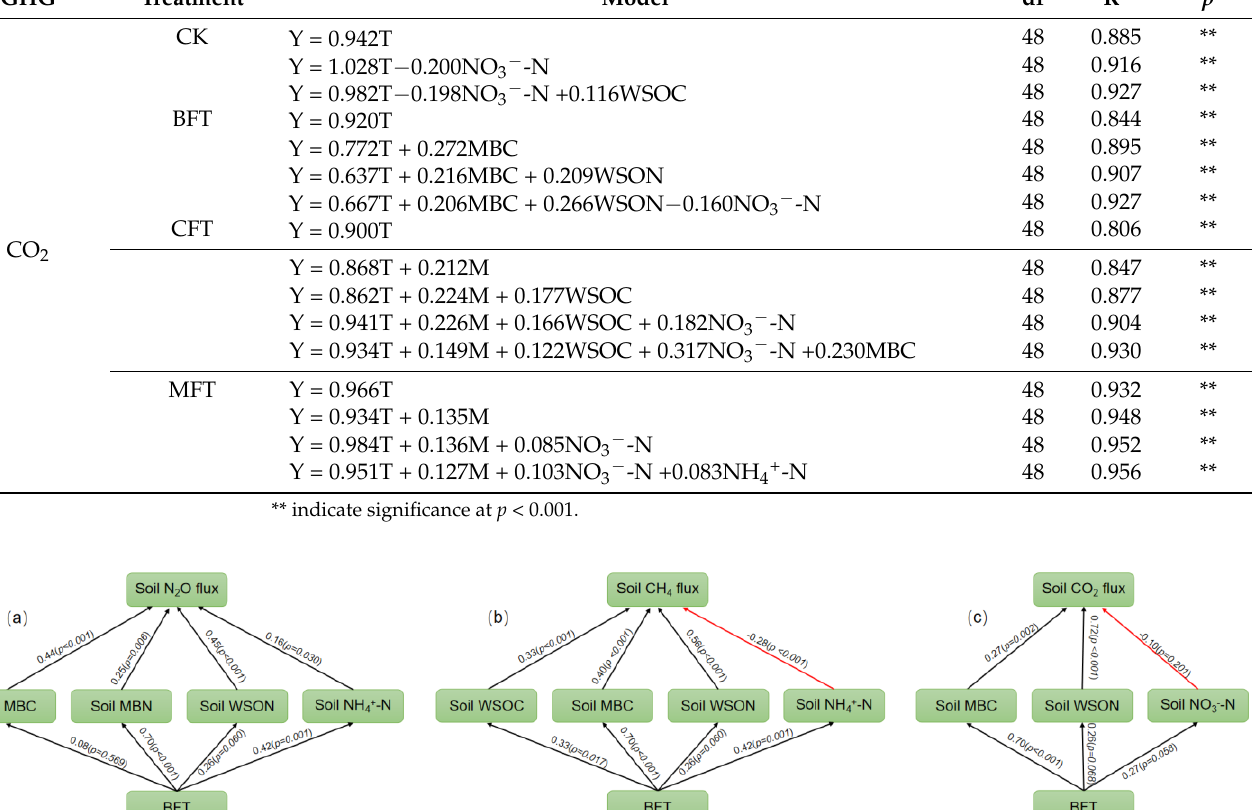
Table 4. Model for stepwise regression analysis between CO 2 flux (mg m − 2 h − 1 ) and soil temperature (T, ◦ C), soil moisture (M, g kg − 1 ), microbial biomass C (MBC, mg kg − 1 ), water-soluble organic C (WSOC, mg kg − 1 ), microbial biomass N (MBN, mg kg − 1 ), water-soluble organic N (WSON, mg kg − 1 ), NO 3 − -N, and NH 4+ -N under CK, BFT, CFT, and MFF treatments. (The coefficient in the model is standardized.) R 2 denotes the percentage of variance revealed by Model.